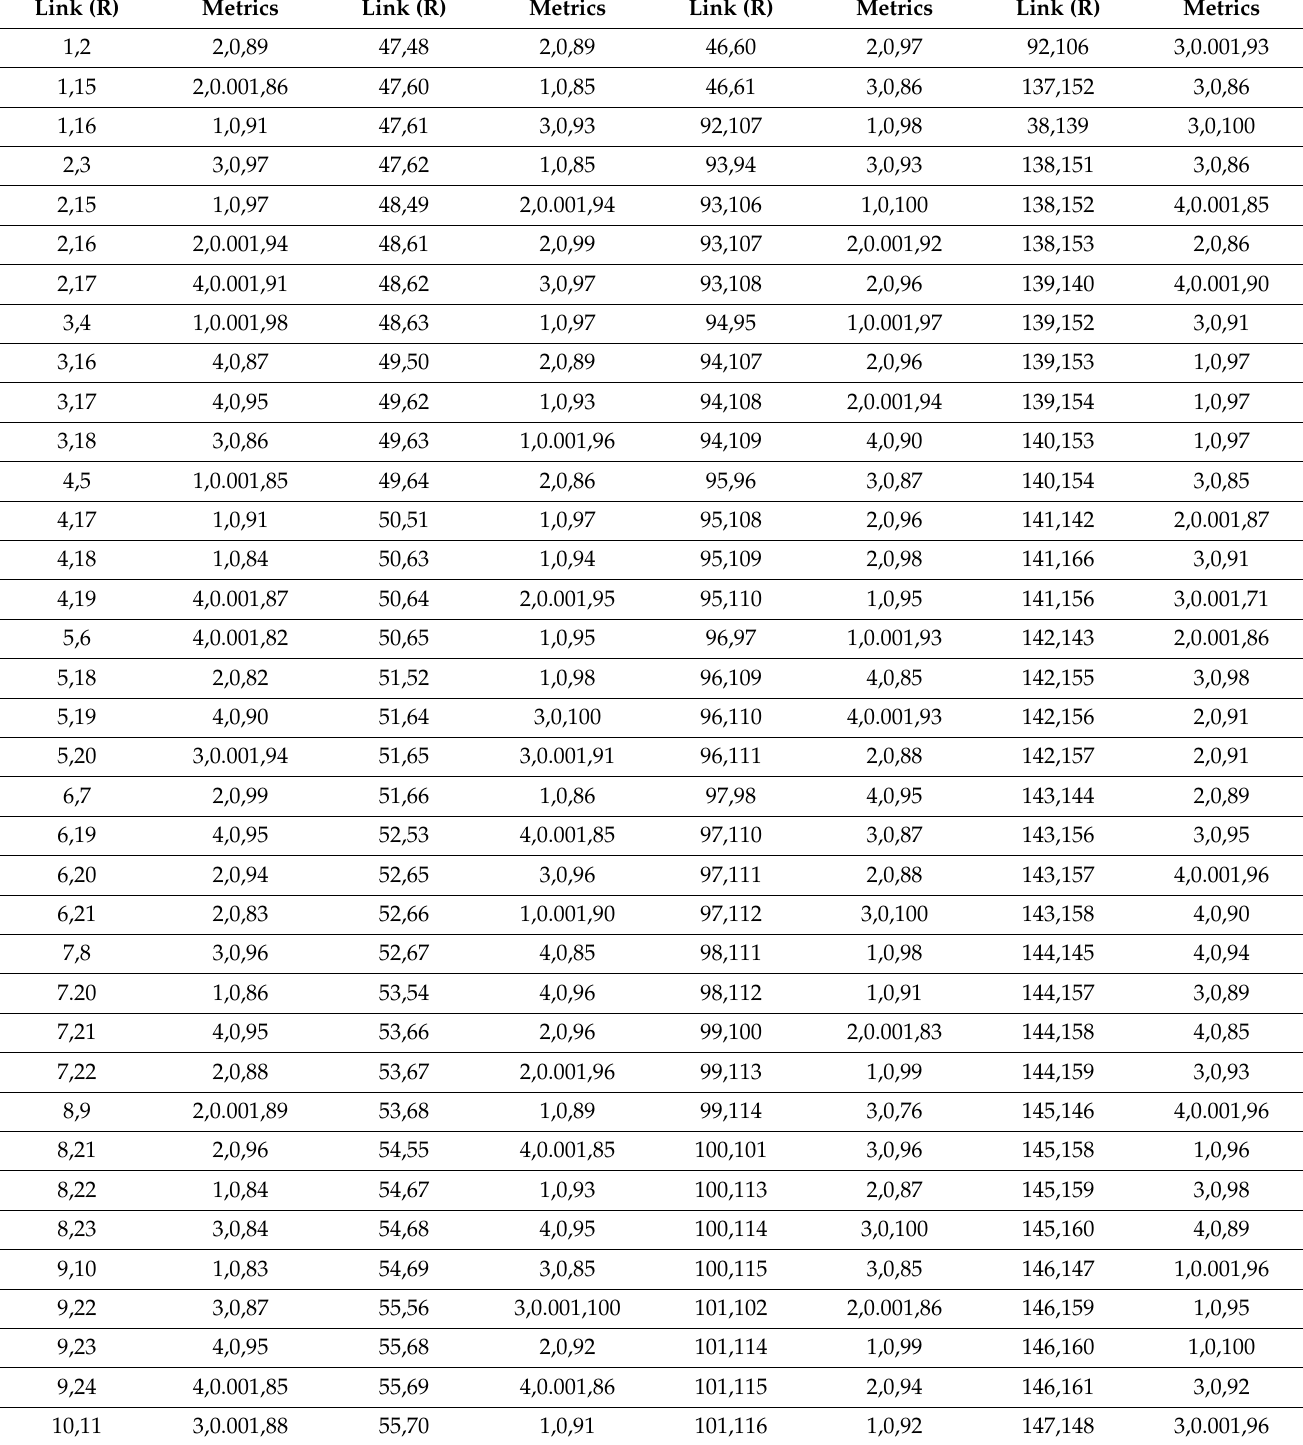
Table A3. Controller C link metrics in the simulation model. Metrics: delay (ms), packet loss (%), and bandwidth